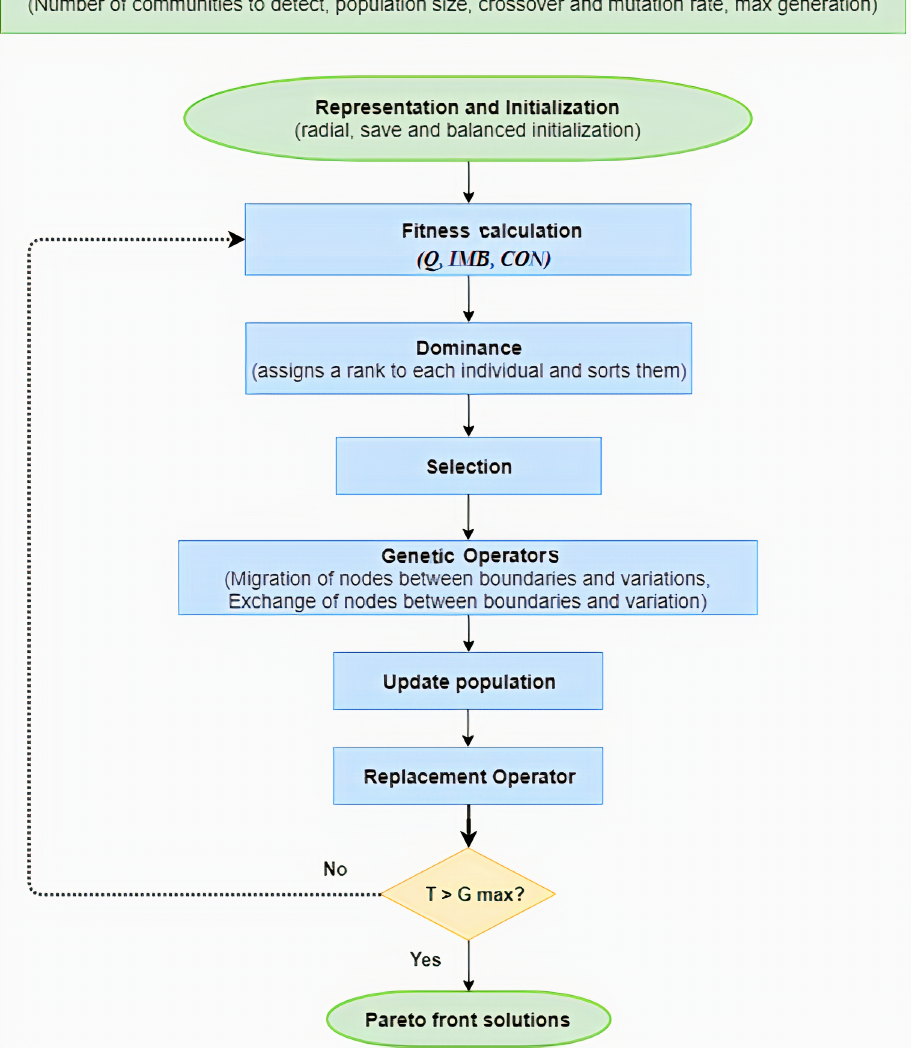
Figure 1. Multi-objective Generational Genetic Algorithm+ (MOGGA+)